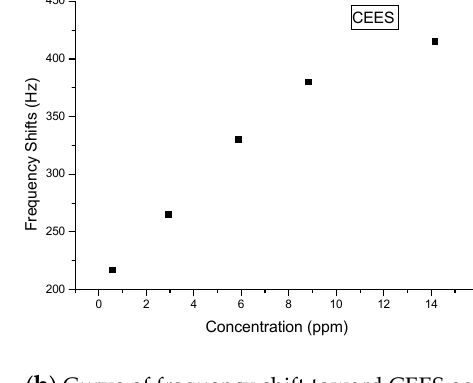
( b ) Curve of frequency shift toward CEES gas Figure 5.